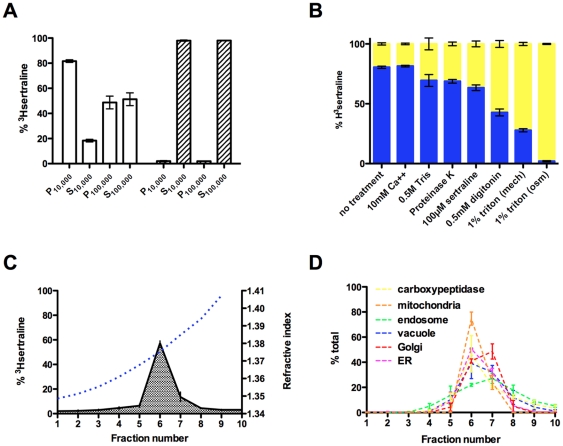
Subcellular fractionation demonstrates [3H]sertraline accumulation in vesiculogenic membranes.(A) The percent [3H]sertraline detected in soluble (“S”) versus pellet (“P”) fractions following sequential centrifugations (10,000×g and 100,000×g) in the absence (white columns) or presence of 0.5% Triton X-100 detergent (hatches). (B) The ratio of soluble (yellow) to P10,000-associated (blue) [3H]sertraline following extraction with a diverse panel of chemical agents. * P<0.05, ANOVA; ** P<0.0001, ANOVA. (C) Distribution of [3H]sertraline across ten equal volume fractions following Optiprep gradient separation of total organellar membranes (P100,000) from wildtype BY4716 cells treated with [3H]sertraline for one hour at 25°C. The refractive index is plotted (blue slashed line) on the left y-axis. (D) Densitometry plots of six organellar markers distributed across the ten gradient fractions. Error bars indicate SEM. Means were generated from three independent biological replicates.